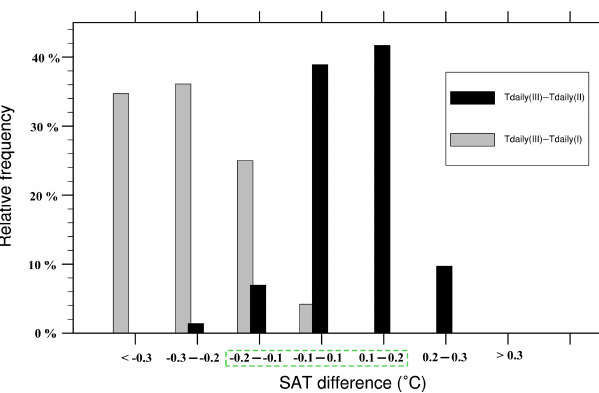
Figure 3. Distribution of difference between the daily mean tem- perature T daily (III) and T daily (I) (gray bars) and difference between T daily (III) and T daily (II) (black bars) in the 72months from Jan- uary 1908 to December 1913 in Qingdao. The SAT differences in the green frame are considered as physically